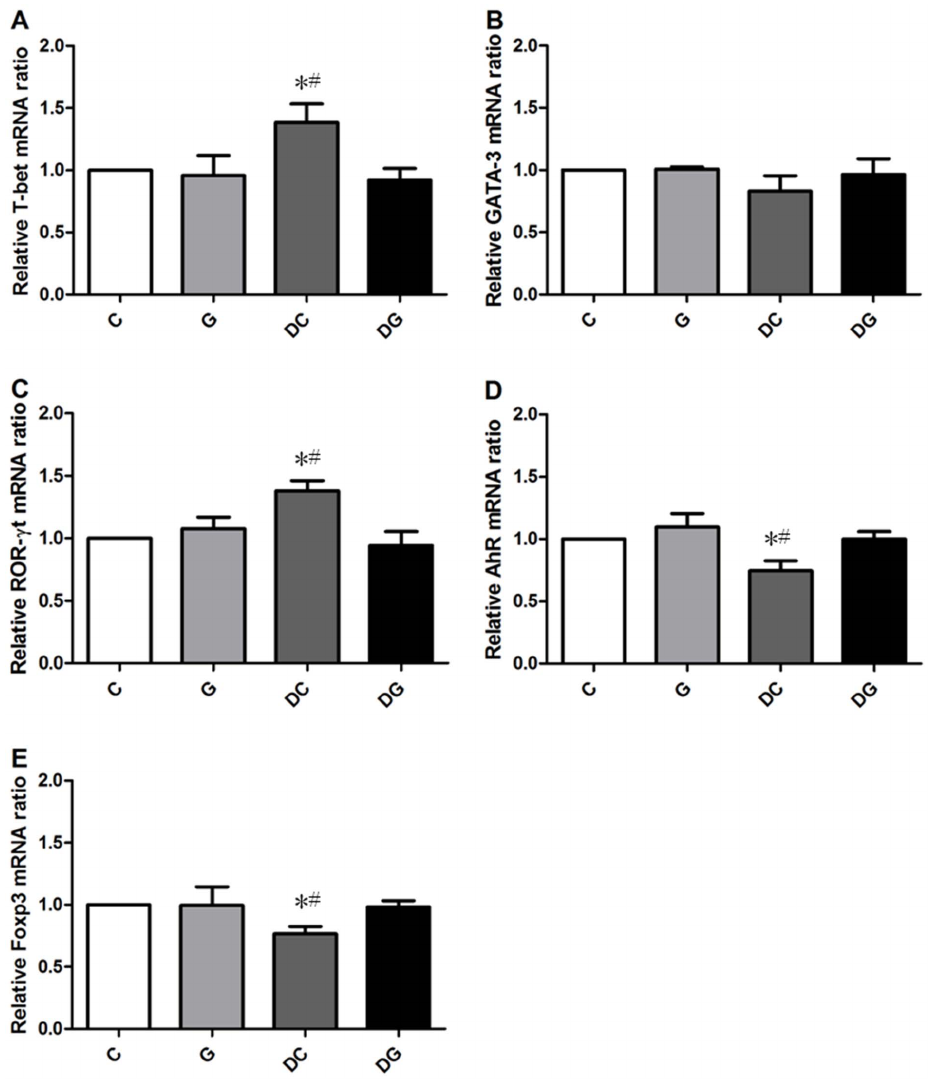
Figure 3. Transcription factor gene expressions of A) T-bet, B) GATA-3, C) ROR- c t, D) the aryl hydrocarbon receptor (AhR), and E) forhead box p3 (Foxp3) in mesenteric lymph nodes (MLNs) were analyzed by a real-time PCR. Quantitation of mRNA changes was calculated by the comparative CT (2 2 DD Ct ) method, and the mRNA expression of C mice was used as a calibrator. Data are shown as the mean 6 SEM. *Significantly differs from the C group. # Significantly differs from the DG group ( p ,